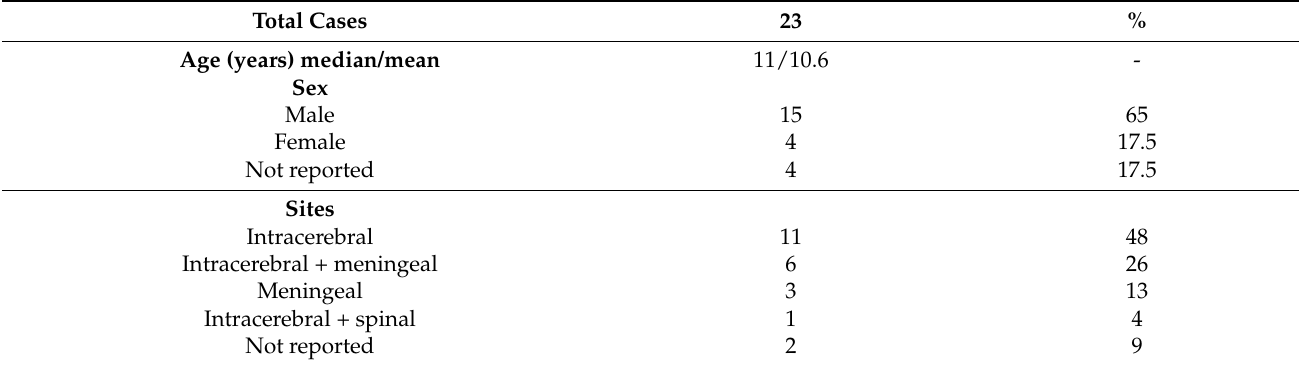
Table 5. Main features of pediatric primary CNS ALCL